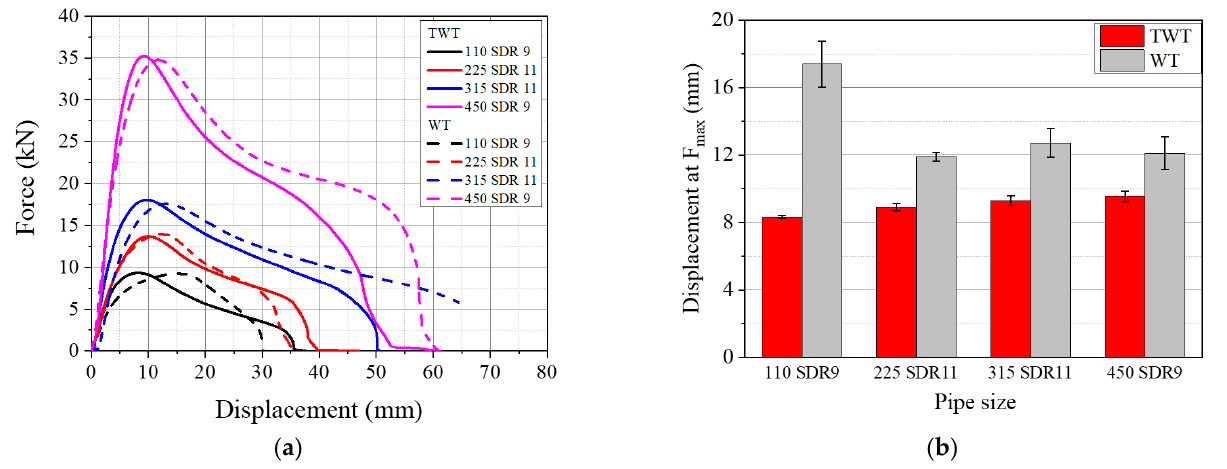
Figure 21. Comparison between TWT and WT specimens: ( a ) Load–displacement curves; ( b ) Onset necking displacement. necking